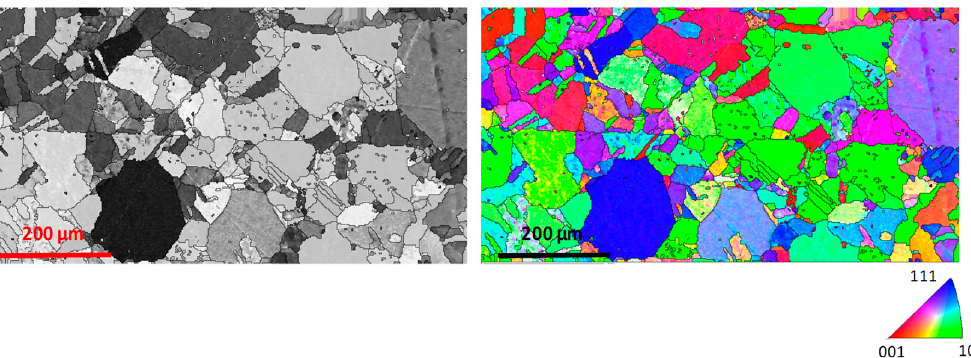
Figure 5. EBSD Band Contrast (left) and Inverse Pole Figure (IPF) (right) maps in the bonding zone. Bonding conditions of specimen: 1000 ◦ C / 90 Bonding conditions of specimen: 1000 °C/90 min.